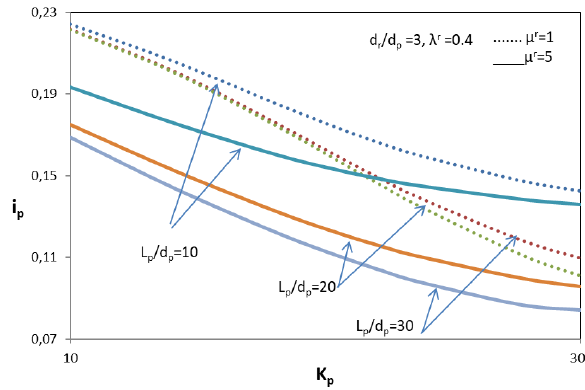
, considering radial displacement with Figure 8: Variation of SIF, i p comparative strengthening, K , of GP– effect of comparative length p of GP, L /d , and stiffness factor, μ r , on partially strengthened GP– p p raft foundation (d /d =3, λ r =0.4). r p